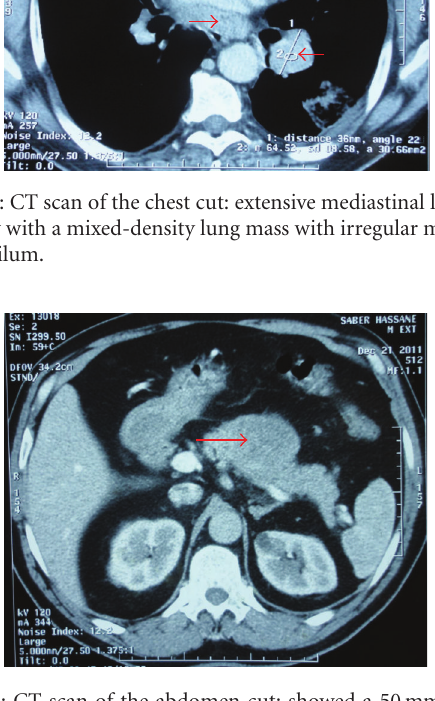
Figure 2: Laterocervical lymphadenopathy biopsy slide: cytomor- phological features at higher magnification view: proliferation of atypical tumor cells with a high nucleocytoplasmic ratio. The nuclei of the tumor cells has salt-and-pepper-type chromatin pattern. Divers mitotic figures are noted.